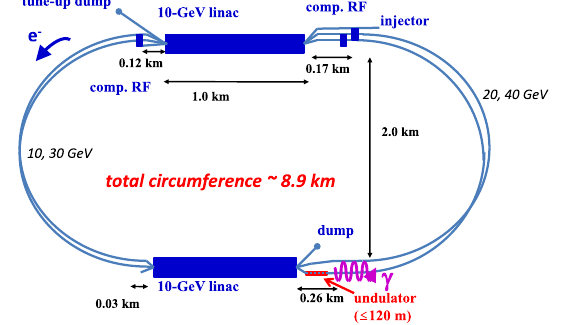
FIG. 1. LHeC recirculating linac reconfigured for FEL